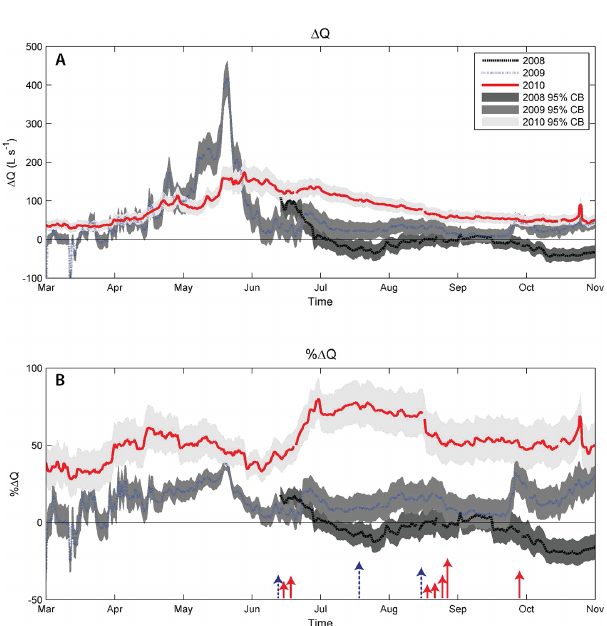
Figure 3. (a) Change in discharge over the study reach calculated from daily average flows where (cid:49)Q is the discharge at outflow (PT1252) minus the upstream discharge at inflow (PT515). Positive values represent increases in discharge and negative values repre- sent decreases in discharge. (b) % (cid:49)Q is the percent change relative to the discharge at inflow (PT515). The 95% confidence interval in three different shades of grey correspond with each individual year. Arrows represent time of individual beaver dam construction. Blue and red arrows correspond with year 2009 and 2010, respectively, while the arrow size is proportional to size of the